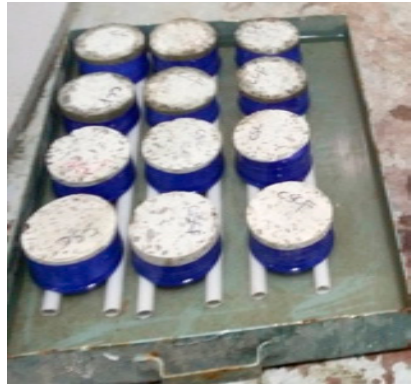
Figure 4. Specimens under sorptivity test.